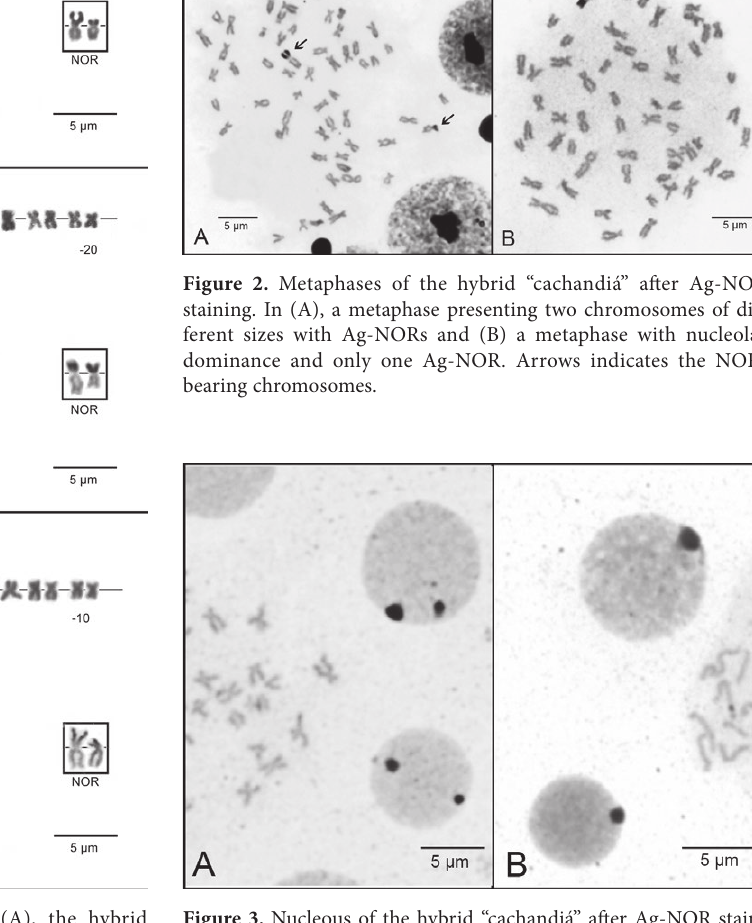
Figure 3. Nucleous of the hybrid “cachandiá” after Ag-NOR stain- ing. In (A), nucleous presenting two Ag-NORs and (B) nucleous with only one